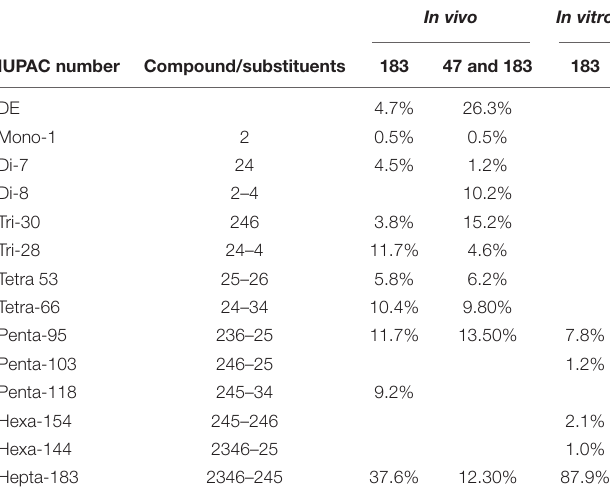
TABLE 1 | Debromination metabolites from hepta-BDE 183 by PB enrichment culture after cultivation ( in vivo ) with BDE 183 solely and co-spike of BDE 47 and 183, as well in enzymatic assays of crude cell extracts ( in vitro ) of cultures spiked with BDE 47.